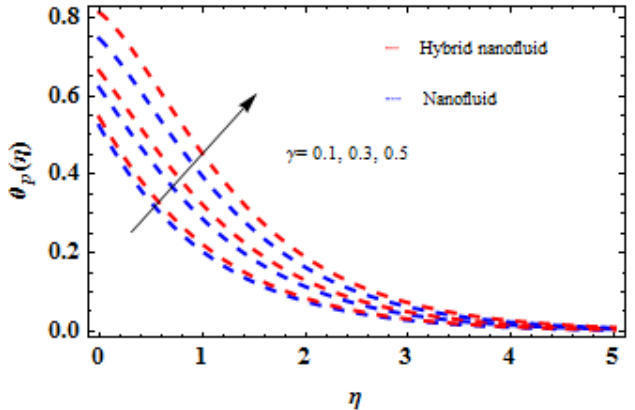
Figure 21. Influence of 𝛾 via dust temperature.